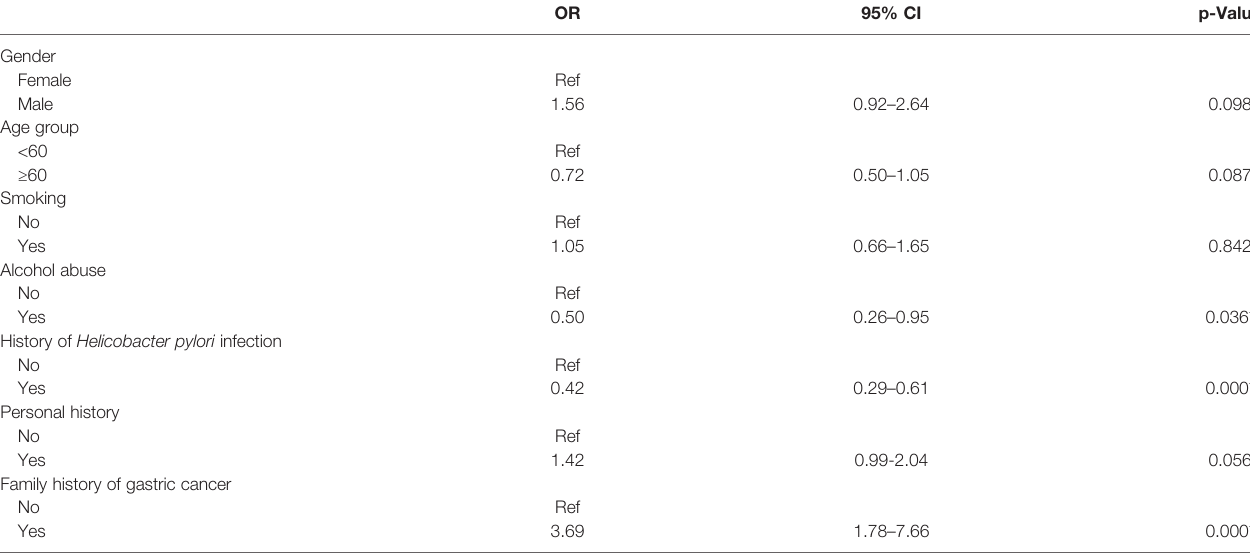
TABLE 3 | Association between environmental factors and risk of gastric cancer: multivariate logistic regression analysis.